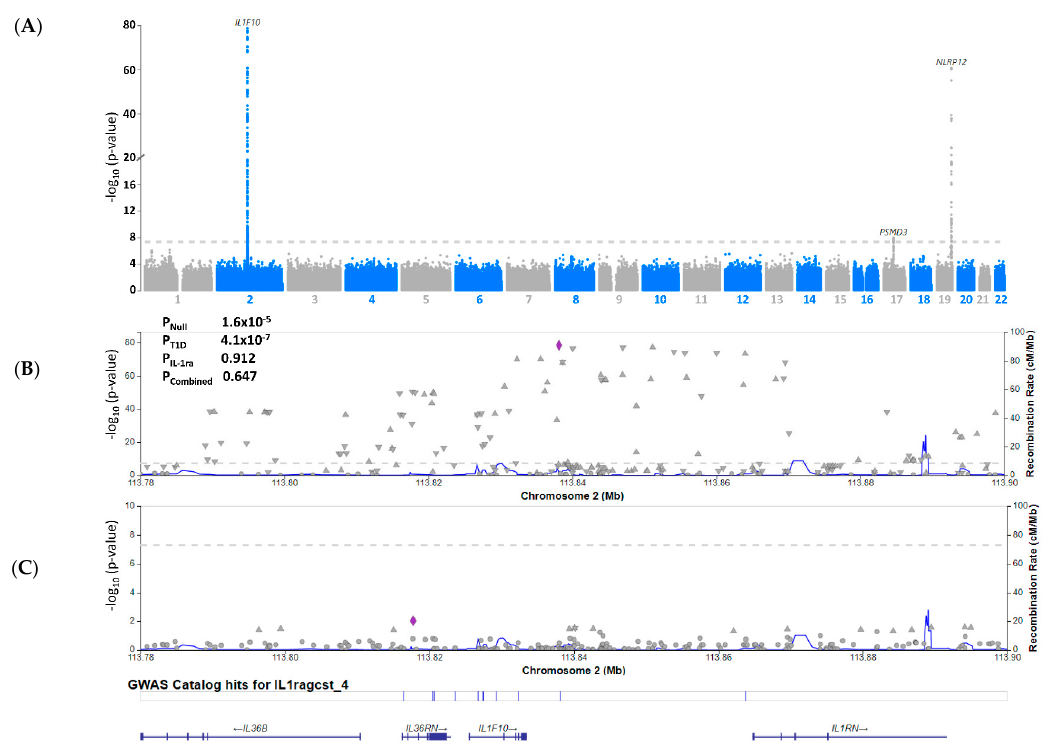
Figure 2. Serum IL-1ra levels are not genetically associated with type 1 diabetes (T1D). ( A ) Man- hattan plot of genetic loci associated with serum IL-1ra levels from Folkersen et al. [22] protein quantitative trait loci study. ( B ) LocusZoom plot of SNPs associated with serum IL-1ra levels in the 2q14.1 region from Folkersen et al. [22] protein quantitative loci (pQTL) study. Association between genetic locus and pQTL was performed using Coloc analysis: P Null : coloc p -value for null hypothesis; P T1D : coloc p -value for genetic locus associated with T1D; P IL-1ra : coloc p -value for association of IL- 1ra protein levels; and P combined : coloc p -value for the combined analysis of genetic risk and IL-1ra pQTL. ( C ) LocusZoom plot of SNPs associated with T1D in the 2q14.1 region from Chiou et al.’s study.